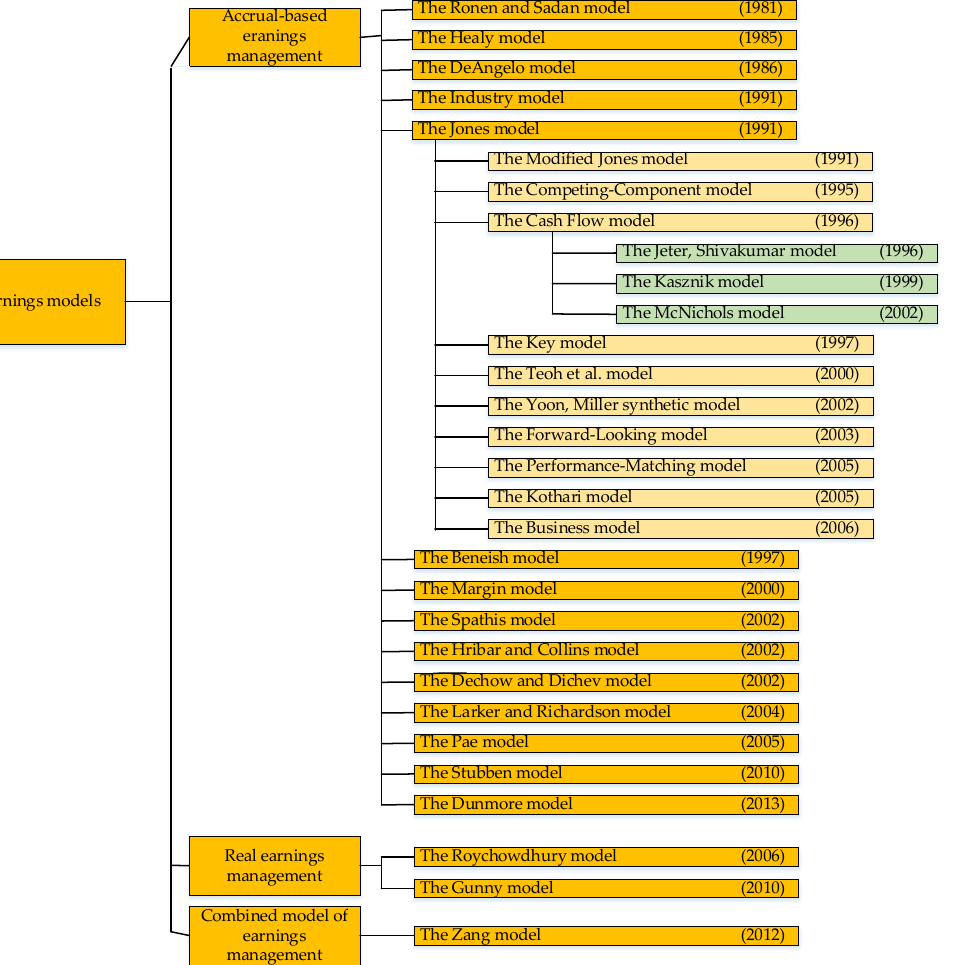
Figure 1. Models of earnings management. Source: Strakova